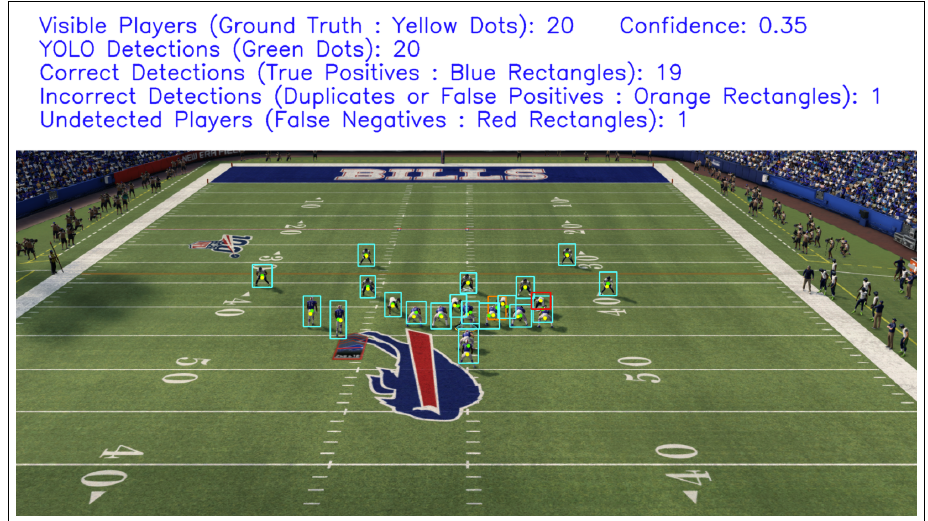
Figure 18. Analysis of player localization Module—The ground truth visible players and the players detected by the module are marked with a yellow and green dot, respectively. The correct detections are marked with a light blue rectangle, the incorrect detections are marked with an orange rectangle, and the players that are missed are marked with a red